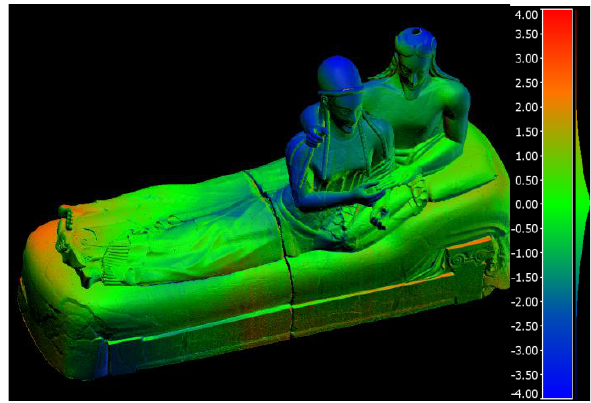
Figure 9. Euclidean distances between the two 3D models digitized using photogrammetry and laser scanning. While on most of the artefacts the 2 approaches delivered very similar results, some local deformations are present in the upper part of the two figures.